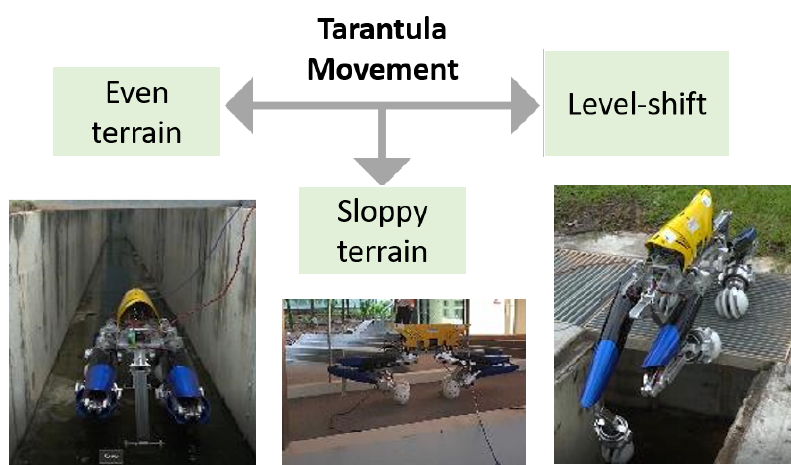
Figure 7. Three distinct types of locomotion for the Tarantula-II platform. For navigation of the robot inside the drain without falling, the robot’s centre of gravity (CG) needs to be actively shifted to maintain an equilibrium position. Thus, it is required to manage the balance of the platform during locomotion on sloppy terrain and level shifting tasks. During locomotion, the controller helps all the wheels to make contact with the terrain. During level shifting, a minimum of three legs are needed to support the whole body. The concept of a support polygon has been applied to study the stability of the platform. The rectangle below the Tarantula platform in Figure 8 represents the support polygon, which is the projection of the contact locations of the wheel on the ground.